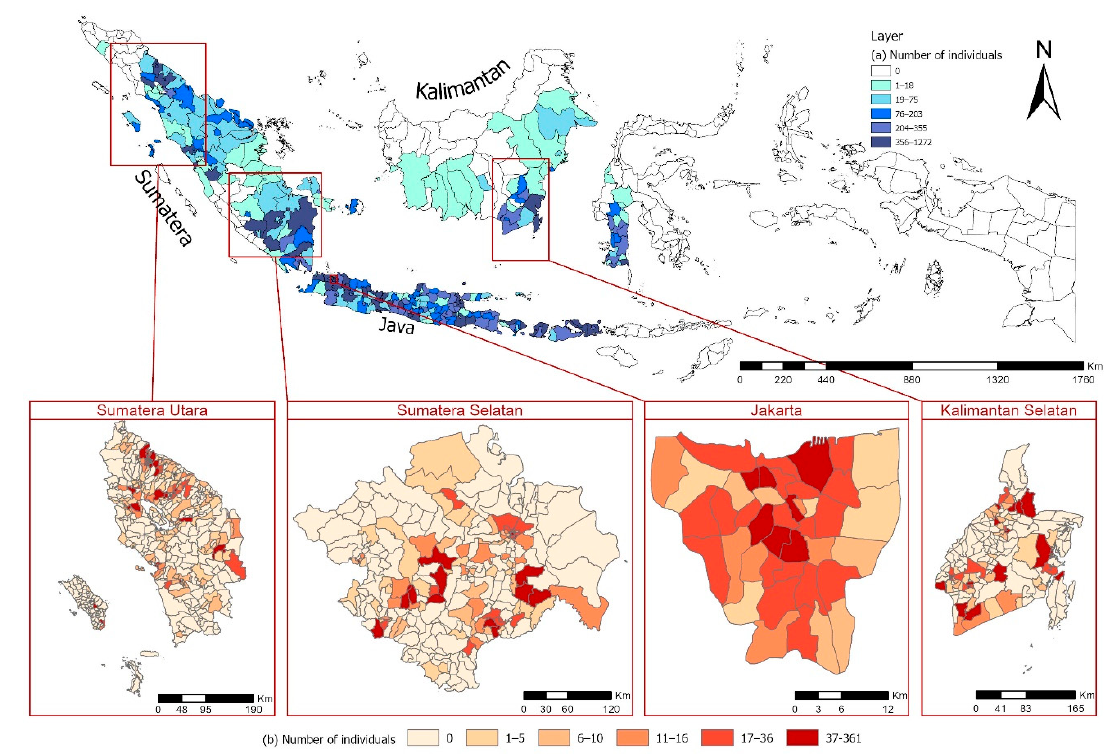
Figure 2. IFLS Wave 5 ( a ) Total number of individual surveyed per district; ( b ) subject density per sub-district at each province.